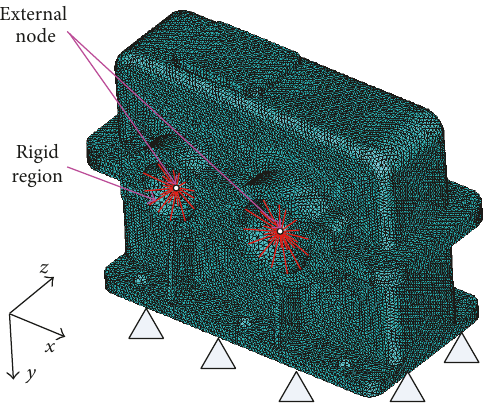
Figure 5: Finite element model of the housing.